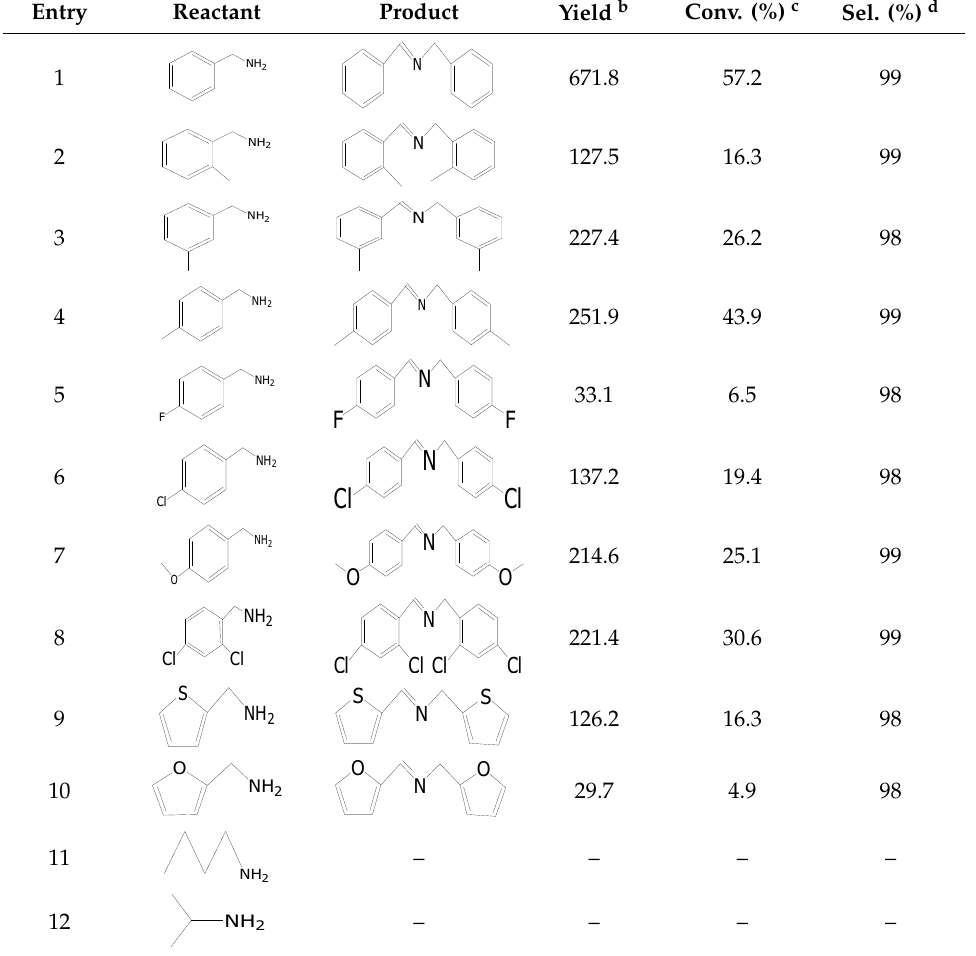
Table 3. a E ff ect of di ff erent amines on photocatalytic activity. Table 3. a Effect of different amines on photocatalytic activity. Table 3. a Effect of different amines on photocatalytic activity. Table 3. a Effect of different amines on photocatalytic activity. Table 3. a Effect of different amines on photocatalytic activity. Table 3. a Effect of different amines on photocatalytic activity. Table 3. a Effect of different amines on photocatalytic activity. Table 3. a Effect of different amines on photocatalytic activity. Table 3. a Effect of different amines on photocatalytic activity. Table 3. a Effect of different amines on photocatalytic activity. Table 3. a Effect of different amines on photocatalytic activity. Table 3. a Effect of different amines on photocatalytic activity. Table 3. a Effect of different amines on photocatalytic activity. Table 3. a Effect of different amines on photocatalytic activity. Table 3. a Effect of different amines on photocatalytic activity.